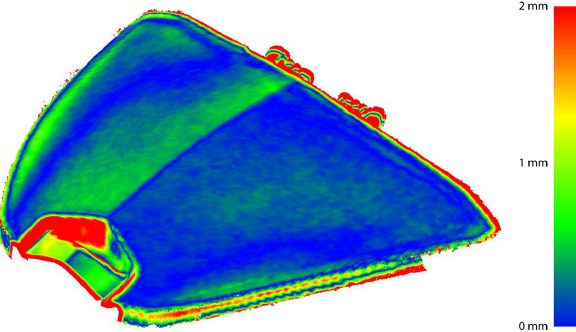
Figure 7: A comparison of the photogrammetric point cloud and Structure Sensor mesh model colored according to absolute devia- tion (in